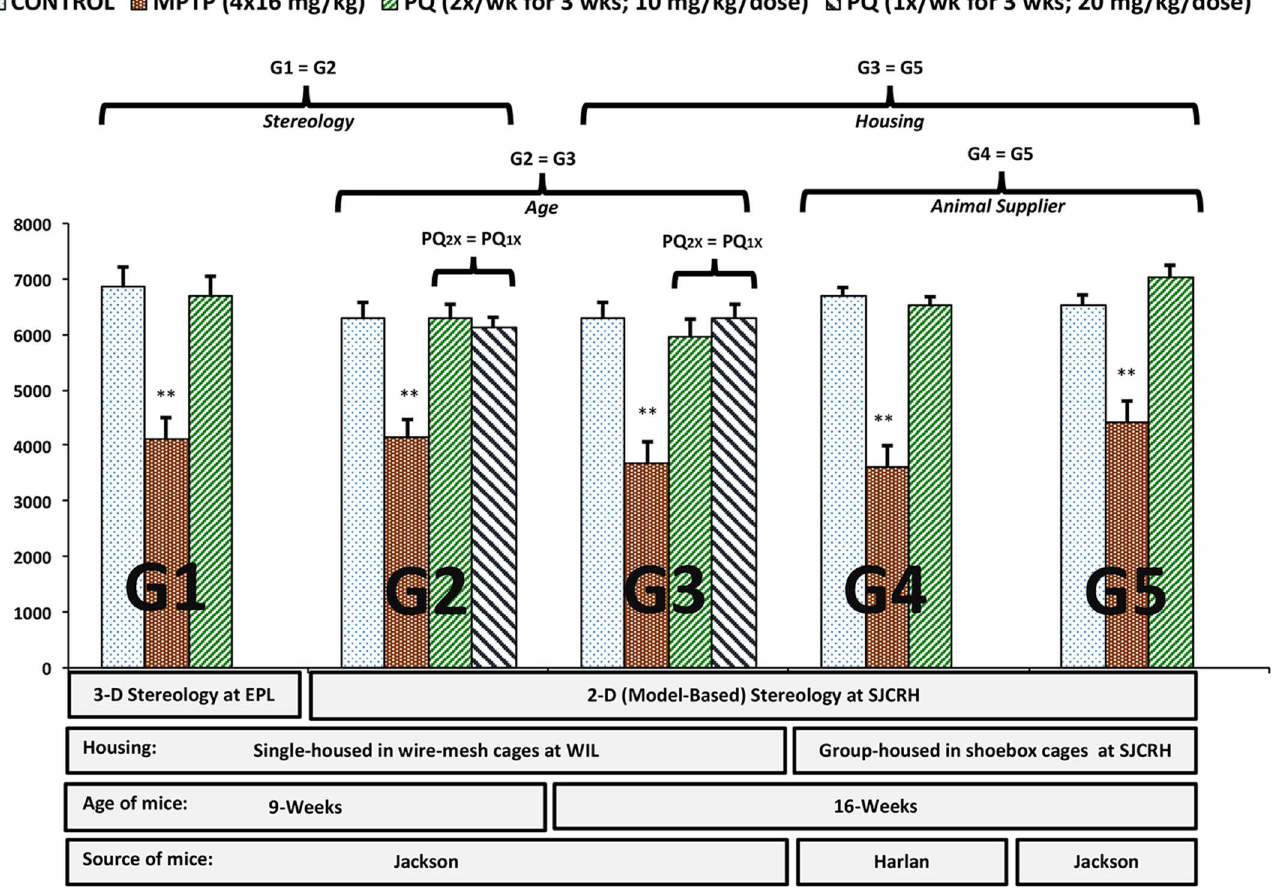
Fig 1. Stereological assessment of the mean number of TH + neurons in the SNpc following PQ or MPTP treatment in C57BL/6J and C57BL/ 6NHsd male mice. Five different groups (G1-G5) of animals, varying in age and site of experiment were injected with saline, paraquator MPTP and the extent of TH + neuron loss was assessed by design-based or model-basedstereology. ** significantlydifferent from control mice (p (cid:20) 0.01). Syngenta-sourced PQ was used to treat mice G1 to G3 mice, whereas Sigma Chemical PQ was used to treat mice in groups G4 and